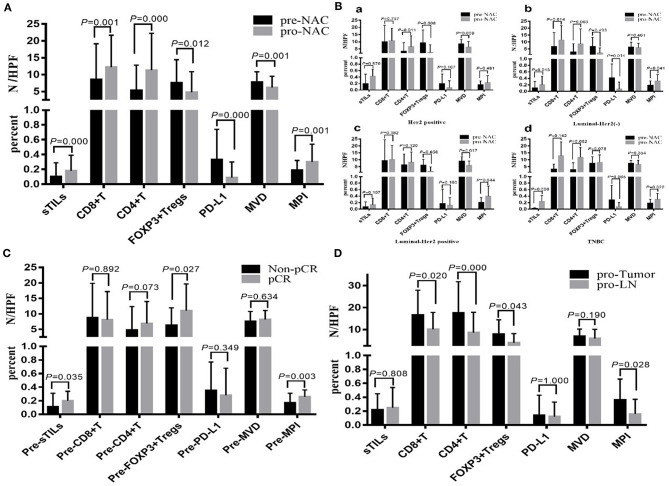
(A) Changes of total sTILs, PD-L1, MVD and MPI before and after NAC. (B) Changes of sTILs, PD-L1, MVD, and MPI before and after NAC in patients with different breast cancer subtypes: a. Her2 positive; b. Luminal—Her2 (–); c. Luminal-Her2 positive; d. TNBC. (C) Comparison of sTILs, PD-L1, MVD, and MPI between Non-pCR group and pCR group before NAC. (D) Comparison of sTILs, PD-L1, MVD, and MPI in primary tumor (pro-Tumor) and metastatic lymph nodes (pro-LN) after NAC (N = 21).